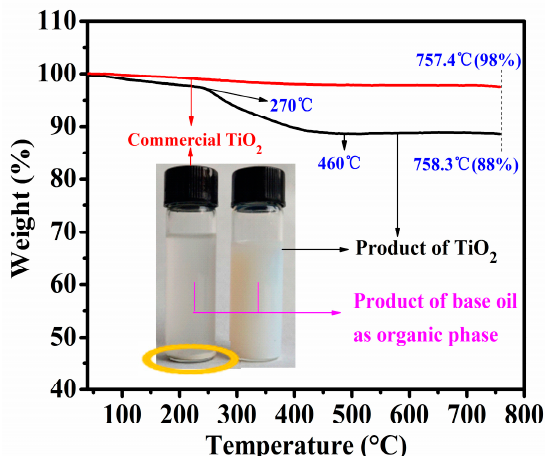
Figure 7. The TG curves of TiO 2 and dispersion stability test of TiO 2 (0.1 wt. %) 60 days after sonication.